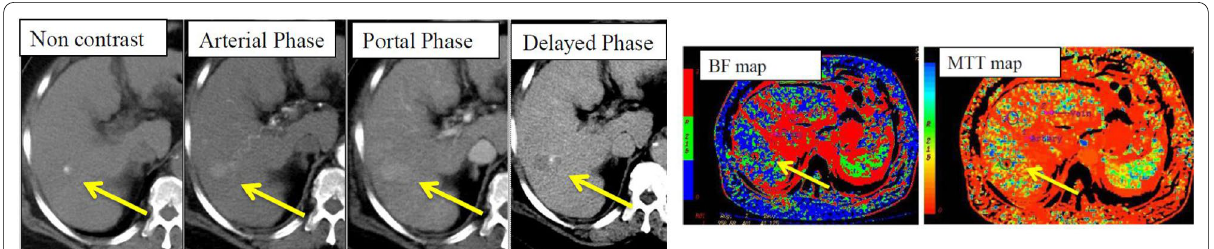
Fig. 4 71-year-old male patient with liver cirrhosis and right hepatic lobe segment VIII HCC underwent TACE on June 2019. Follow-up post-intervention triphasic CT was done on August 2019 and revealed dense injected chemotherapy material “lipidol” showing evidence of pathological enhancement at its lower margin, denoting recurrent/residual activity. CTP functional maps of this recurrent lesional pathological activity showed evident increase in blood flow measuring about 239 mL/100 g/min compared to 96 mL/100 g/min in the non-ablated hepatic parenchyma. In addition, the mean transit time is reduced to become 8